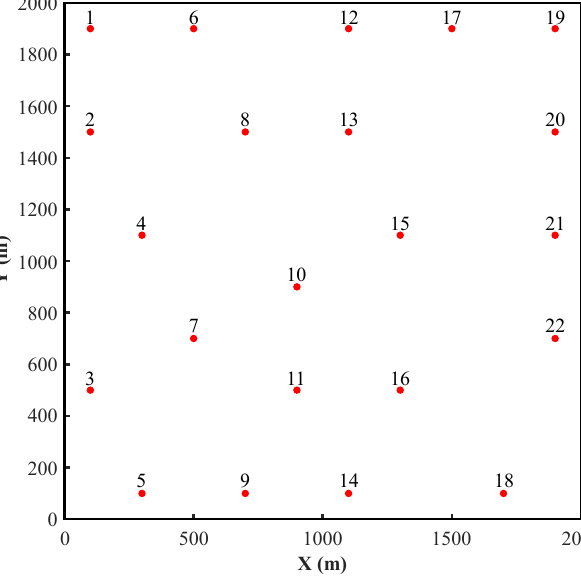
Figure 11. Optimal WFLO with a zero wake effect.